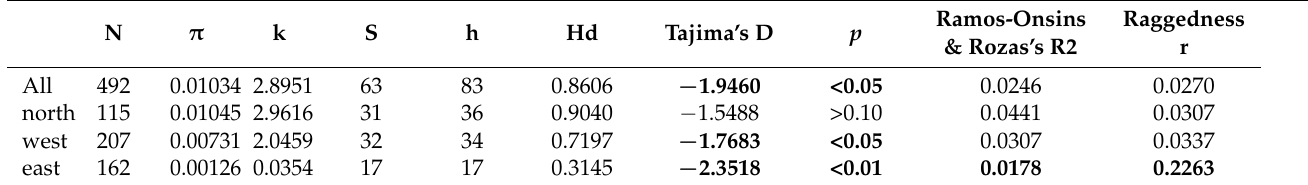
Table 3. Summary statistics of regional variation among partial mtDNA cytochrome-b sequences from Acanthophlebia cruentata mayflies in New Zealand ( π , nucleotide diversity; k, average number of nucleotide differences; S, number of segregating sites; h, number of haplotypes; Hd, haplotype diversity), and ‘neutrality’ statistics that can indicate population size change. Significantly negative values of Tajima’s D (bold) imply population expansion under the assumption of locus neutrality. R2 represents the relationship between singleton mutations and average nucleotide difference with a smaller value (bold) consistent with a scenario of population expansion. A larger value (bold) of the Raggedness statistic r indicates a poor fit with the assumption of constant population size. Regional groupings as shown in Figure 4 and Table 1.